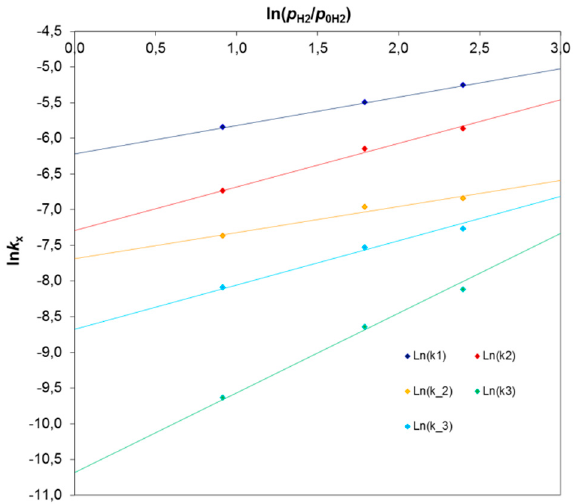
` ˘ { p 0H “ 1 bar p a q p H ; p 0H 2 2 2